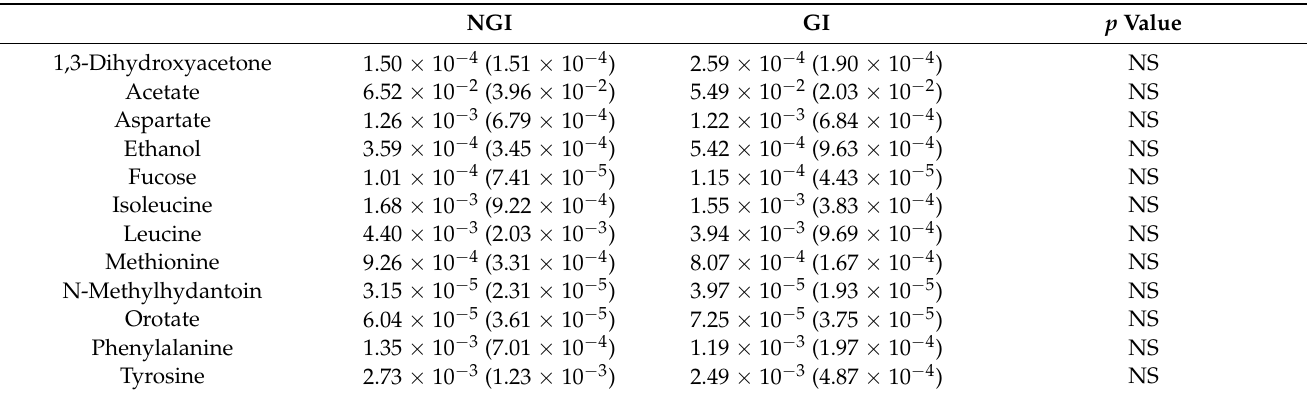
(Figure 2). Table 2. Concentration (mmol/L; median (IQR)) in the samples from moderate-ADOS children of the molecules significantly different between samples from high-ADOS and low-ADOS children.